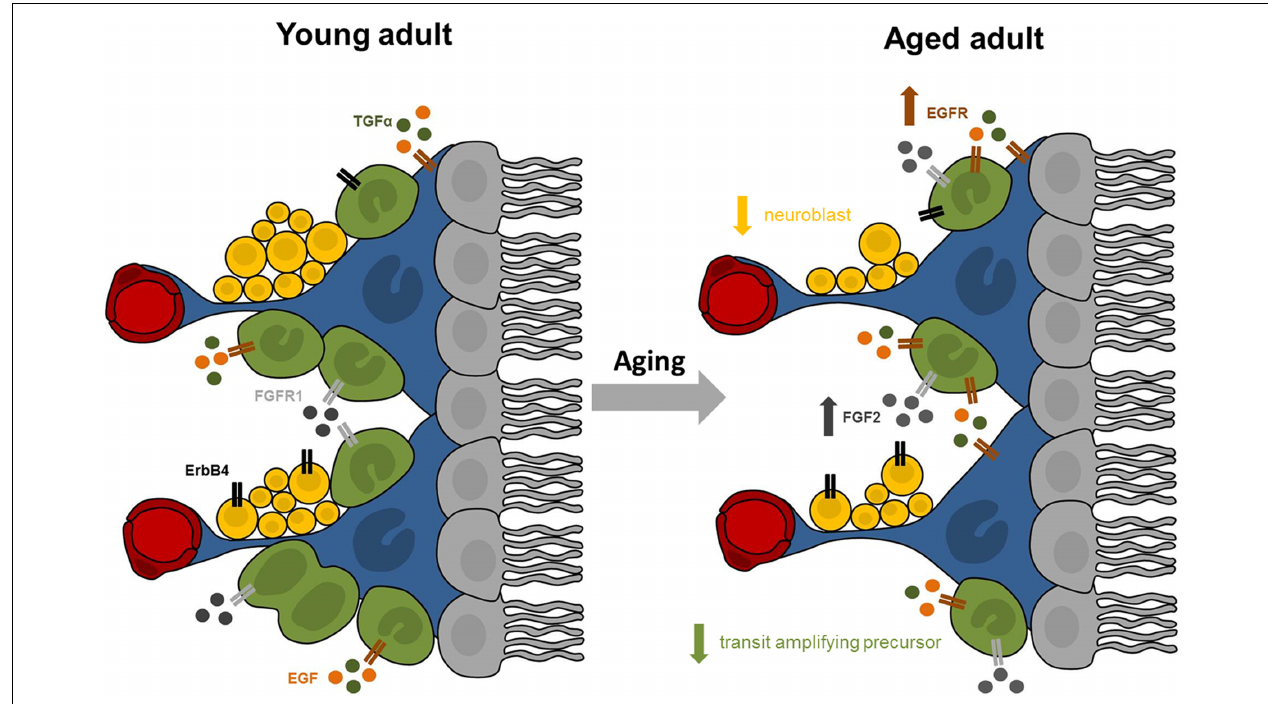
FIGURE 6 | Summary of proposed age-related changes in the human SEZ. The adult SEZ is organized below a ciliated ependymal monolayer (in gray) and includes quiescent stem cells with astrocyte-like properties (in blue), transit amplifying precursor cells (in green), neuroblasts (in yellow), and blood vessels (in red). Our results indicate that the aged SEZ has a significantly reduced number of transit amplifying precursors and neuroblasts, while the number of stem cells remained stable. These age-related changes may be modulated by altered expression of growth factors and their receptors. Expression of EGFR (in brown) was significantly increased with advanced age, while transcript levels of FGFR1 (in light gray) and ErbB4 (in black) were unchanged. The major endogenous ligands for EGFR are EGF (in orange) and TGF α (in dark green), whose expression remained stable in the aging SEZ. Expression of FGF2 (in dark gray), primary ligand for FGFR1, significantly increased with